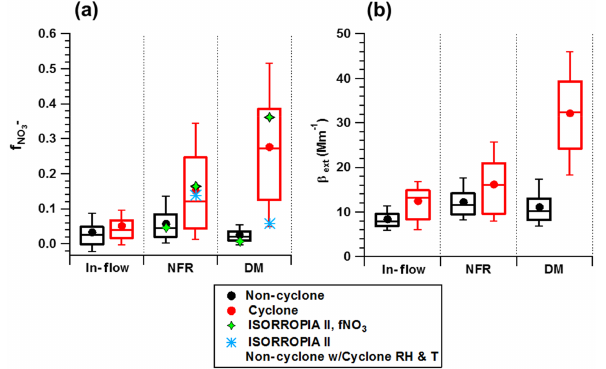
Figure 13. Statistical representation of the distribution of + HNO (a) aerosol nitrate fraction ( f NO 3 = NO − /[NO − 3 ] and 3 3 (b) aerosol optical extinction within the three studied regions dur- ing non-cyclone and cyclone periods. The box and whiskers indi- cate 10th, 25th, 75th, and 90th percentiles, while the solid lines and circles mark the median and mean values, respectively. Modeled f NO 3 values with actual inputs of chemical composition and T and RH are shown with green diamonds, while the predicted values with the non-cyclone composition and cyclone T and RH are shown with blue